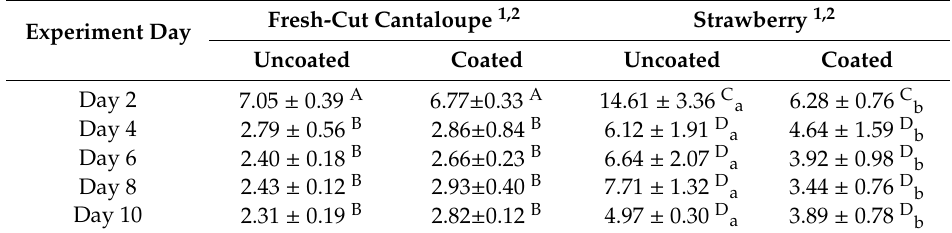
Table 2. Water vapor resistance (WVR) (s / cm) of uncoated and coated fresh-cut cantaloupe and strawberry samples throughout a 10-day storage period ( n = 4). (Coating formulation: 1.25%